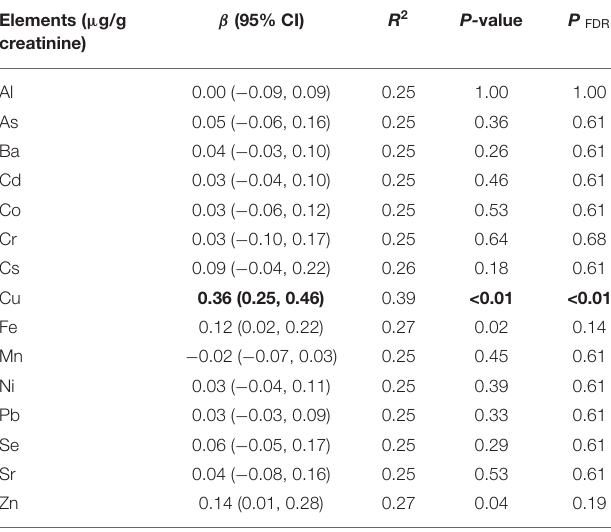
TABLE 3 | Estimated associations between urinary elements and UACR in GLM a . Elements ( µ g/g